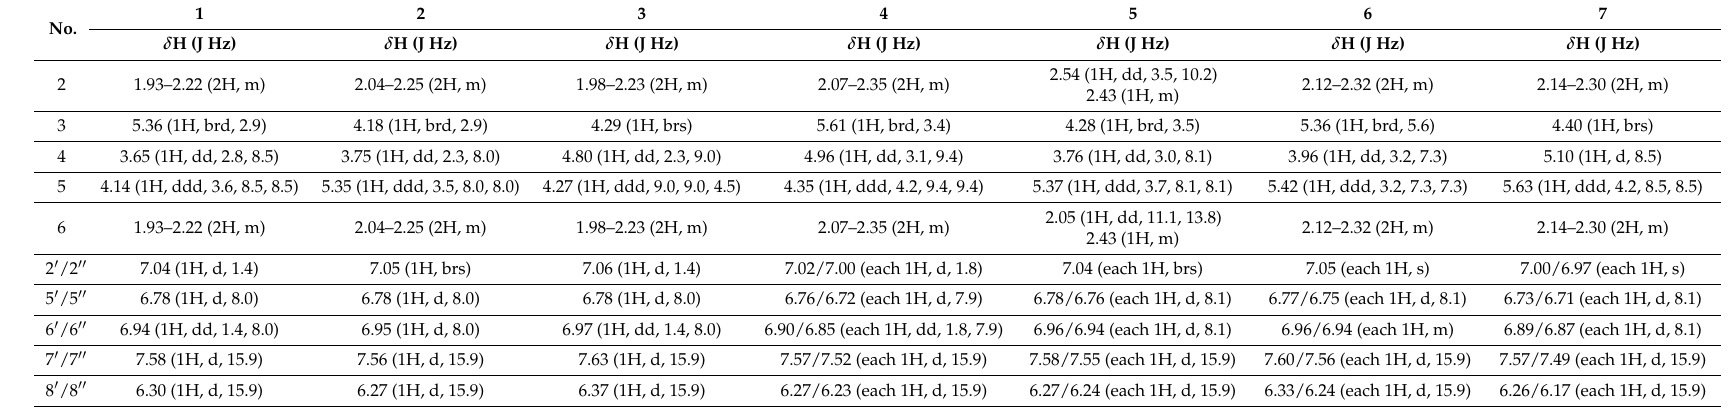
Table 1. 1 H-NMR ( 1 H-Nuclear Magnetic Resonance, 400 MHz, MeOH- d 4 ) characteristics of the caffeoylquinic acid derivatives 1 – 7 isolated from aerial parts of Ch. coronarium